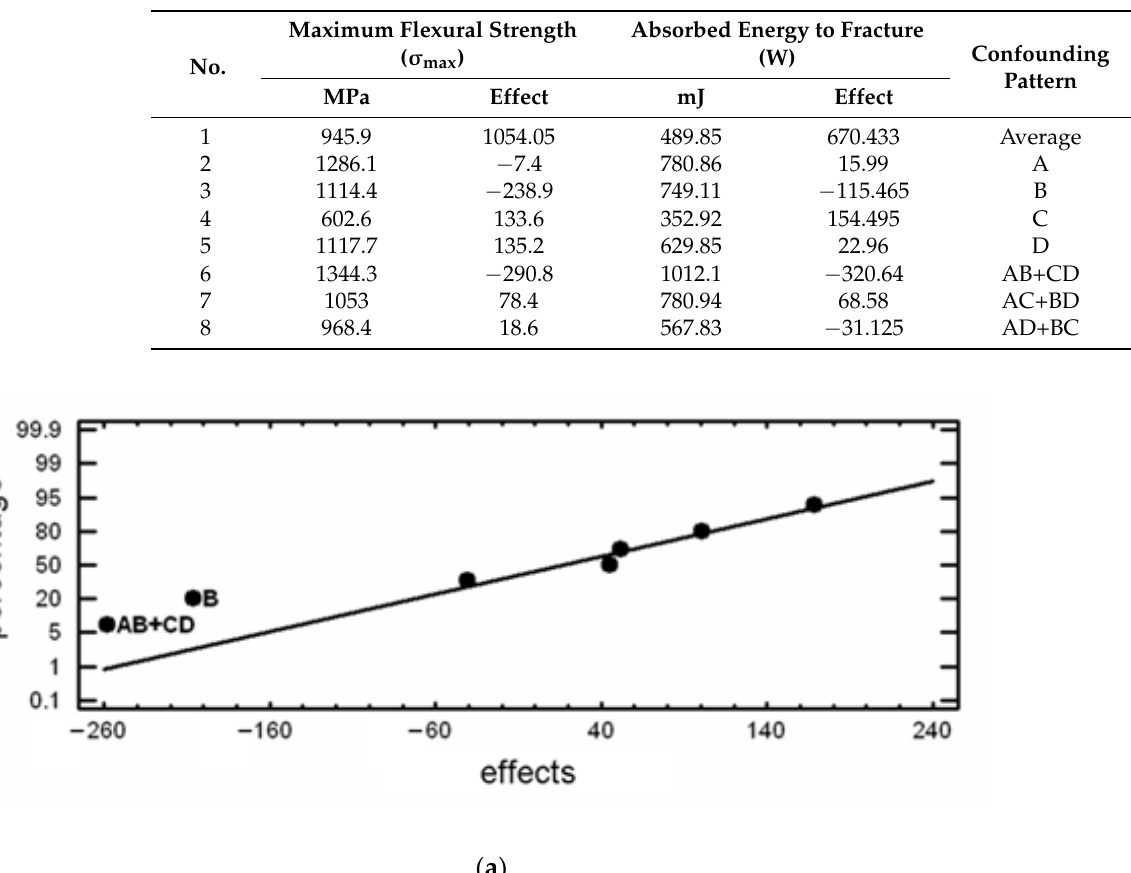
Table 8. Mean values and effects obtained for maximum flexural strength and the energy absorbed to fracture.